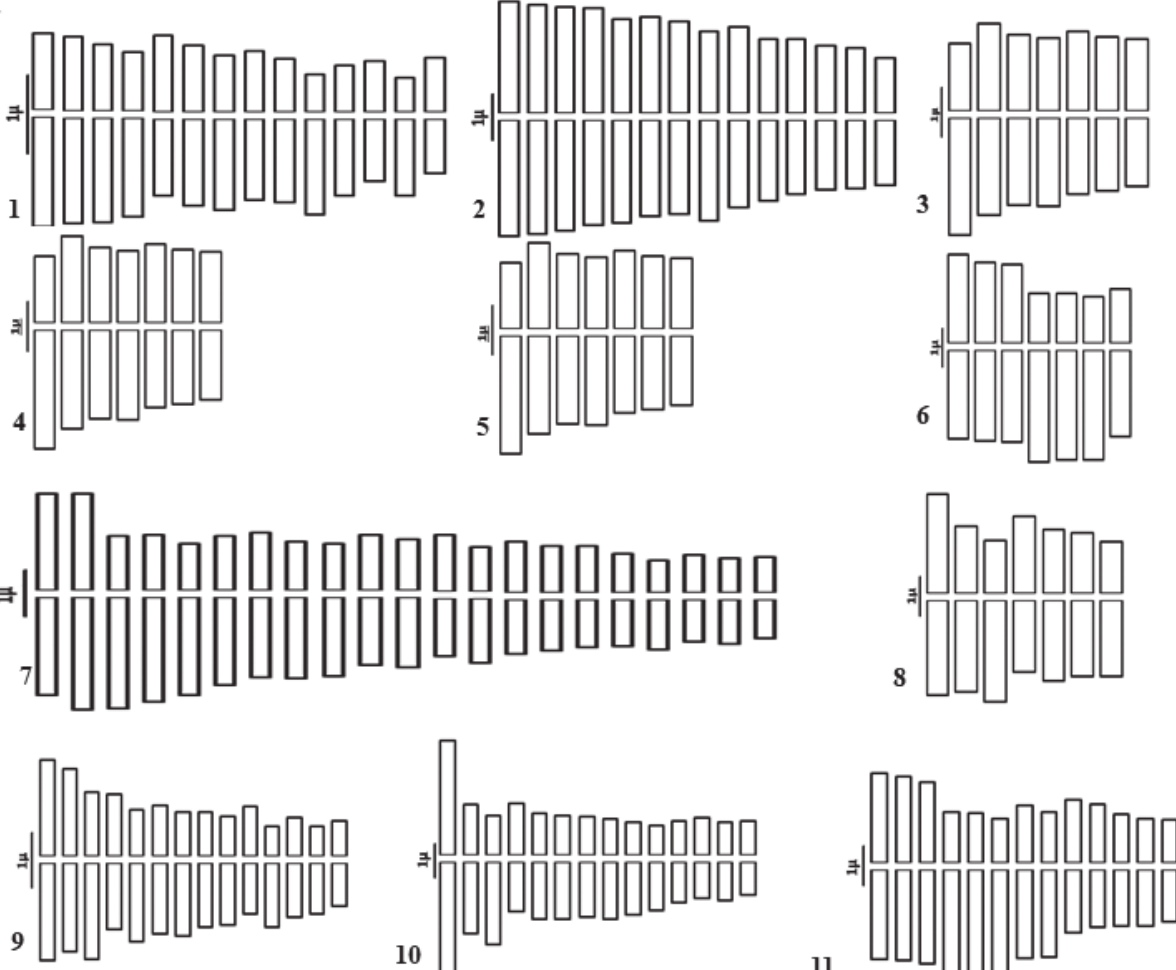
Figure 6. Haploid idiogram in Cuscuta taxa 1 . C. campestris, 2 . C. hyalina , 3 . C. kotschyana, 4. C. babylonica, 5 . C. europaea 6. C. kurdica , 7. C. brevistyla, 8. C. planiflora, 9 . C. approximata , 10 . C. lupuliformis 11 . C. palaestina